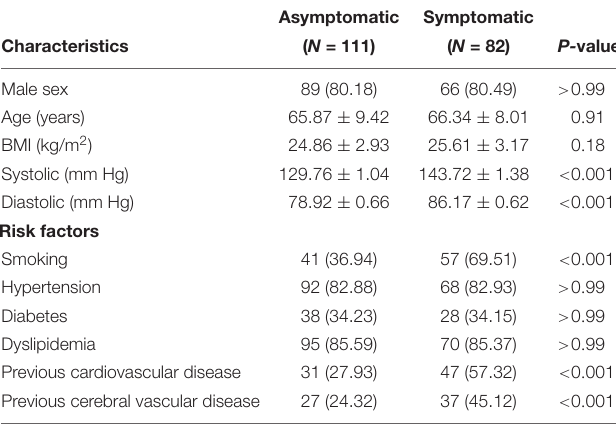
TABLE 1 | Demographic and baseline characteristics of study